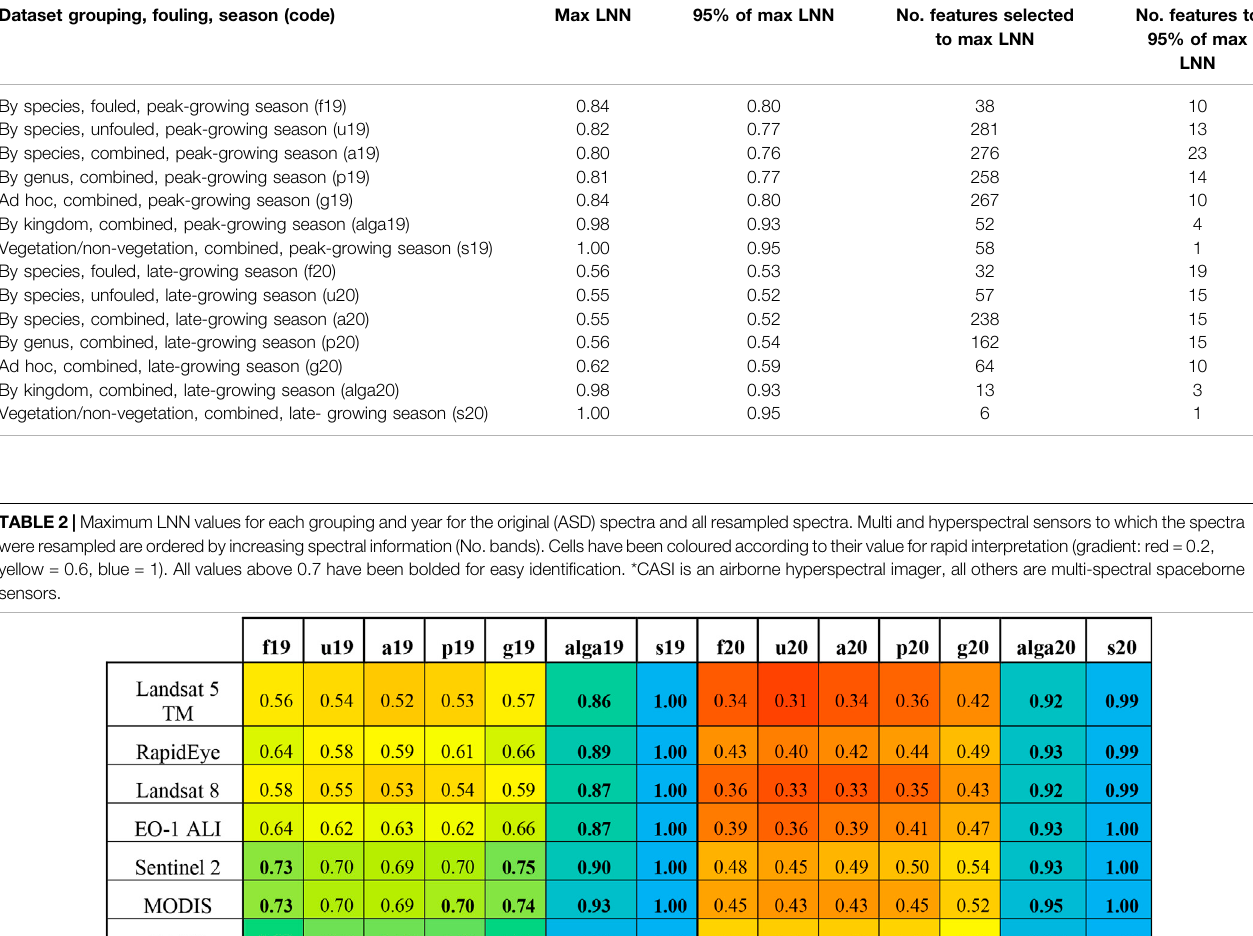
No. features to to max LNN 95% of max